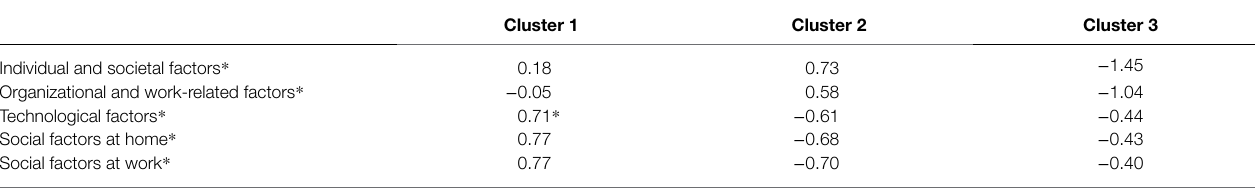
TABLE 5 | Factor average scores per cluster.